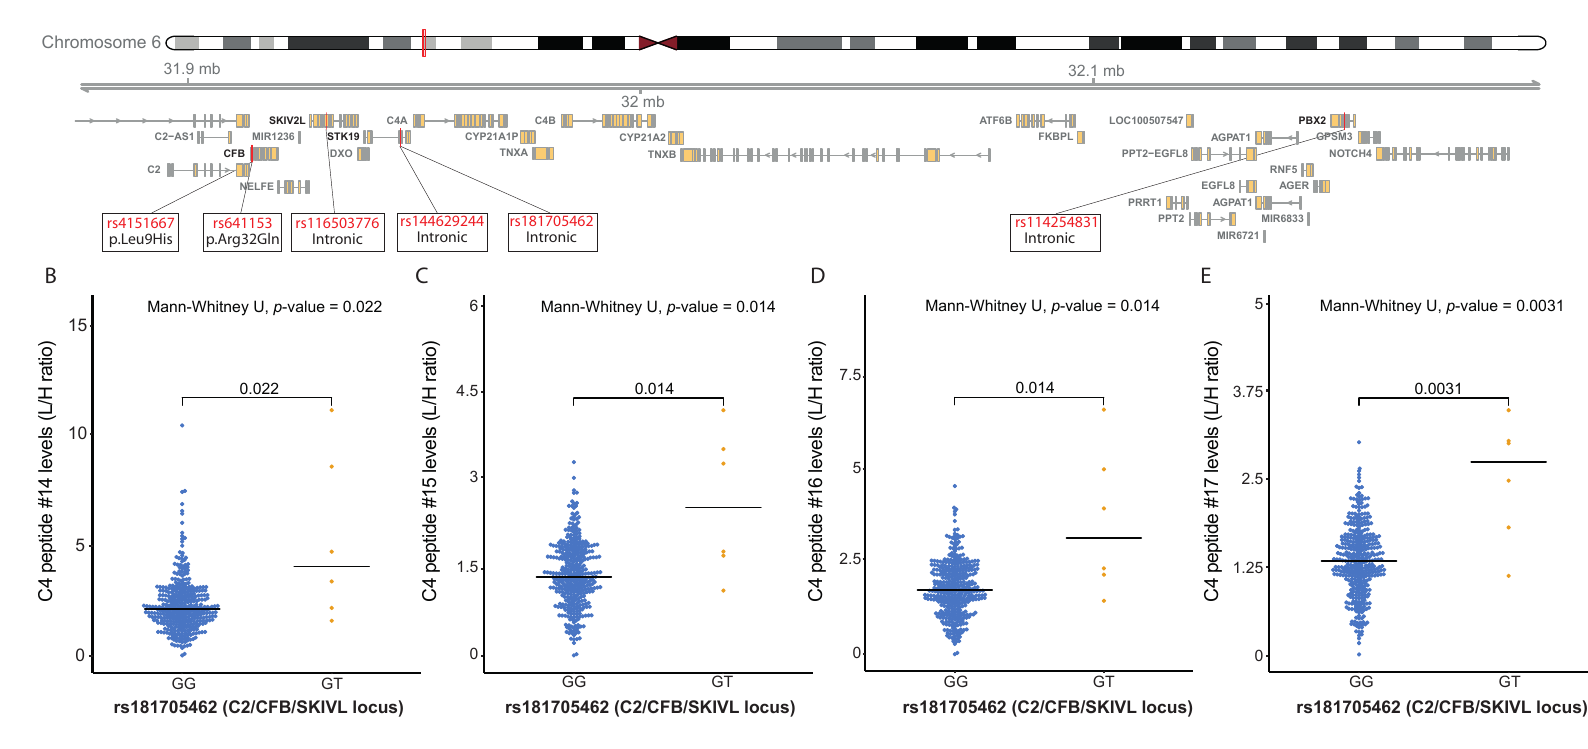
Figure 3. Complement C4 peptide levels show significant differences between genotype groups of AMD-associated variants at the C2/CFB/SKIV2L locus. Blue shows the homozygous AMD protective genotype and yellow indicates the heterozygous genotype. Medians of two genotype groups were compared with the Mann–Whitney-U test. ( A ) Overview of the C2/CFB/SKIV2L locus, showing the four top AMD-associated variants at this locus and two coding variants in CFB tagged by rs116503776, indicating their location in relation to the genes at this locus. Graphs showing the distribution of peptide levels in light/heavy (L/H) in blood plasma for ( B ) complement C4 peptide #14 (DFALLSLQVPLK), stratified by rs181705462 genotype at the C2/CFB/SKIV2L locus; ( C ) complement C4 peptide #15 (VDFTLSSER), stratified by rs181705462 genotype at the C2/CFB/SKIV2L locus; ( D ) complement C4 peptide #16 (VGDTLNLNLR), stratified by rs181705462 genotype at the C2/CFB/SKIV2L locus; ( E ) complement C4 peptide #17 (SHALQLNNR), stratified by rs181705462 genotype at the C2/CFB/SKIV2L